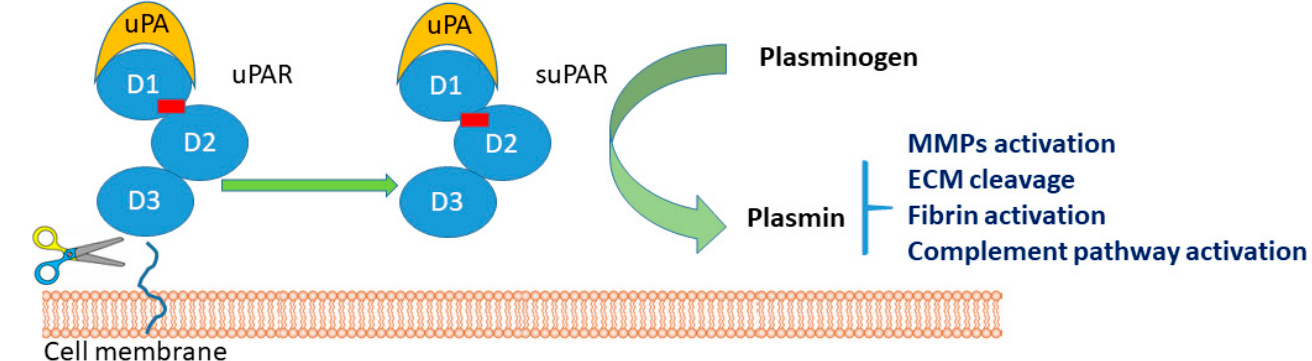
Figure 1. Schematic representation of the urokinase plasminogen activation (uPA) system. D1, D2, and D3 represents the three domains of the protein. The red line represents the linker region between D1 and D2–D3 domains. Active uPA cleaves plasminogen to plasmin that activates matrix metalloproteases (MMPs degrade fibrin), cleaves extracellular matrix (ECM) components, and activates the complement pathway.